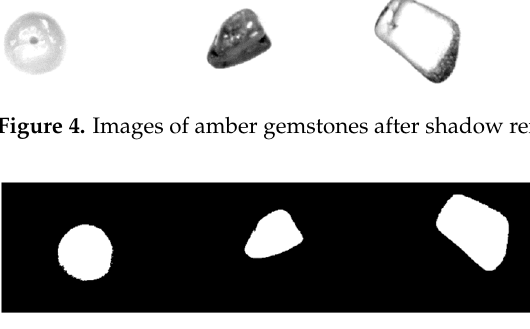
Figure 5. Amber gemstone representation in white